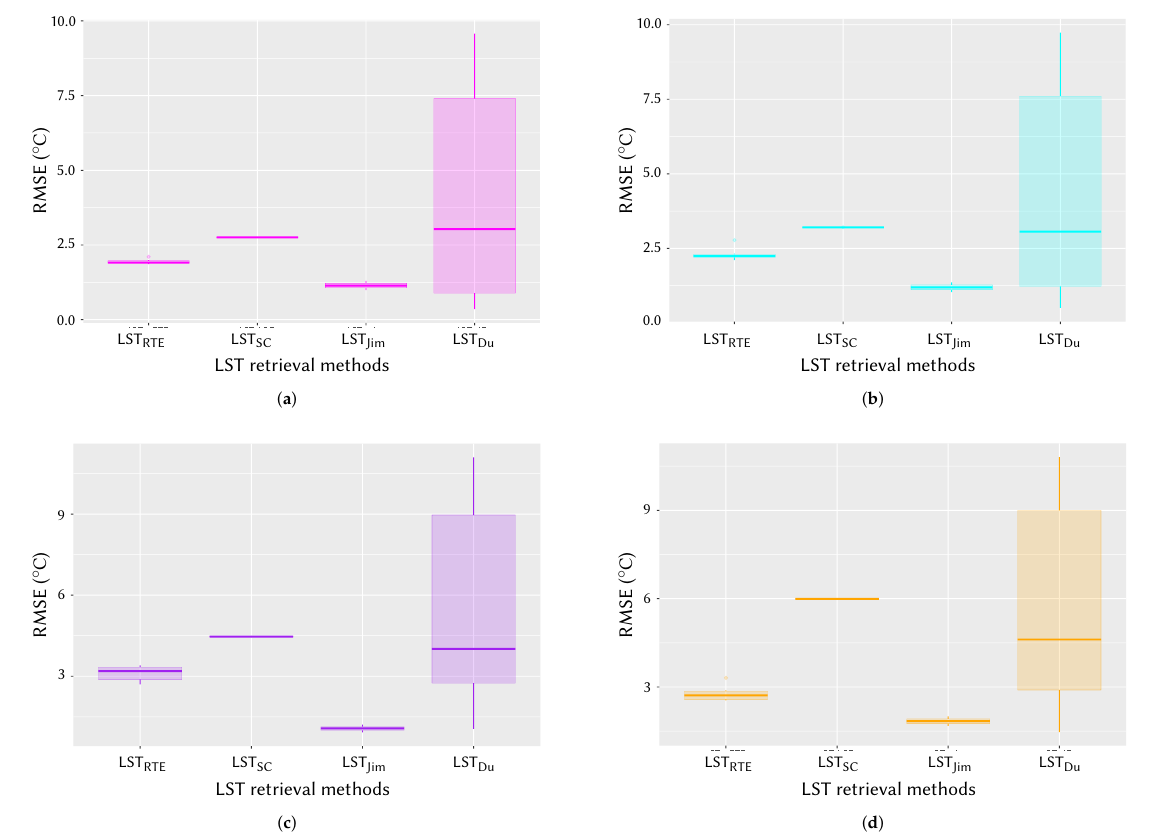
Figure 10. Box plots showing RMSEs of four LST retrieval algorithms as obtained from four Landsat 8 images: ( a ) 4 January 2018 image, ( b ) 20 January 2018 image, ( c ) 9 March 2018 image, and ( d ) 25 March 2018